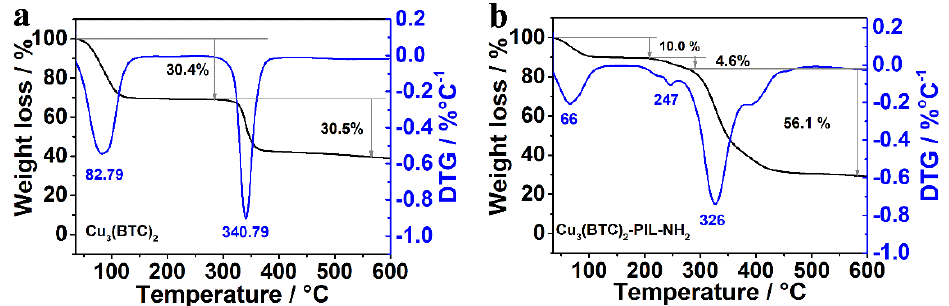
Figure 5. ( a ) TG (black) and DTG (blue) curves of Cu 3 (BTC) 2 . ( b ) TG (black) and DTG (blue) curves of Cu 3 (BTC) 2 -PIL-NH 2 . The corresponding weight loss values are listed in the figure.